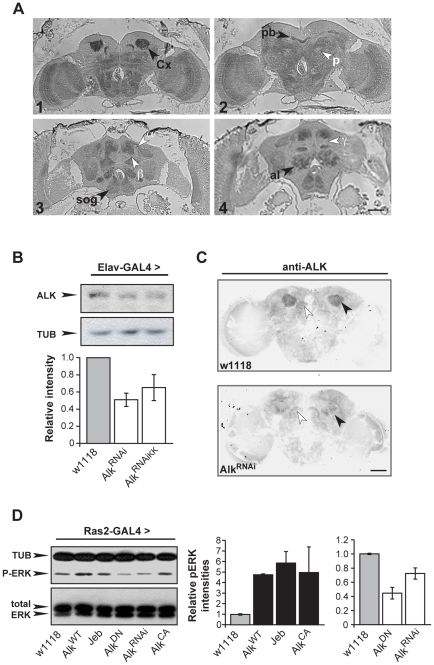
dAlk protein is an active RTK expressed in the adult CNS.(A) Frontal paraffin sections stained with an anti-dAlk antibody, demonstrate accumulation of the receptor in neuropil areas, especially in the Calyx (Cx) (1) the protocerebral bridge (pb) (2) the suboesophageal ganglion (sog) (3,4) and antennal lobe (al) (4) marked with black arrowheads. dAlk is absent from the α, β, and γ lobes of the mushroom bodies and pedunculus (p; white arrowheads) (3,4). Bar = 50 µm. (B) A representative semi-quantitative immunoblot and its quantification illustrate significant reduction of endogenous dAlk upon RNAi-mediated abrogation using two different UAS-AlkRNAi transgenes (UAS-AlkRNAi and UAS-AlkRNAiKK) when driven with Elav-Gal4 . ANOVA indicated significant effects of genotype (F(2,15) = 6.51, p<0.01, n = 5). Student's t-test revealed significant differences between controls and the two different UAS-AlkRNAi lines (p<0.004 and p<0.02 for UAS-AlkRNAi and UAS-AlkRNAiKK, respectively). Tubulin levels served as loading control. (C) Immunohistochemical demonstration of anti-dAlk antibody specificity in adult brain. Representative 40 µm confocal z-stacks from brains of adult w1118 (upper panel) and flies expressing the UAS-AlkRNAi transgene under control of the MB-specific c772-Gal4 driver stained with the anti-dAlk antibody. dAlk accumulation within the dendrites (black arrowhead) of wild type flies was highly reduced in the dendrites of flies expressing the UAS-AlkRNAi transgene. White arrowheads point to the protocerebral bridge where the Gal4 driver is not expressed, showing equal levels of staining between control and experimental flies. Confocal images were acquired within the same range and using the same acquisition settings. They were then converted to grayscale and inverted. Scale bar = 50 µm. (D) Manipulation of dAlk activity in Ras2-expressing neurons affects ERK phosphorylation levels. Representative semi-quantitative immunoblot (left) and its quantification (right) showing alteration of ERK phosphorylation levels upon expression of dAlk transgenes in the Ras2-expressing cells. Levels of pERK were significantly higher upon over-expression of UAS-AlkWT , UAS-Jeb and UAS-AlkCA relative to w1118 control (p = 0.04, p = 0.0053, p = 0.03 respectively, n = 3, Student's t-test). Accordingly, pERK levels were significantly lower upon expression of UAS-AlkDN or UAS-AlkRNAi transgenes relative to w1118 control (p = 0.0002 and p = 0.01, n = 3, Student's t-test). The amount of total-ERK protein is not affected. Error bars denote S.E.M.